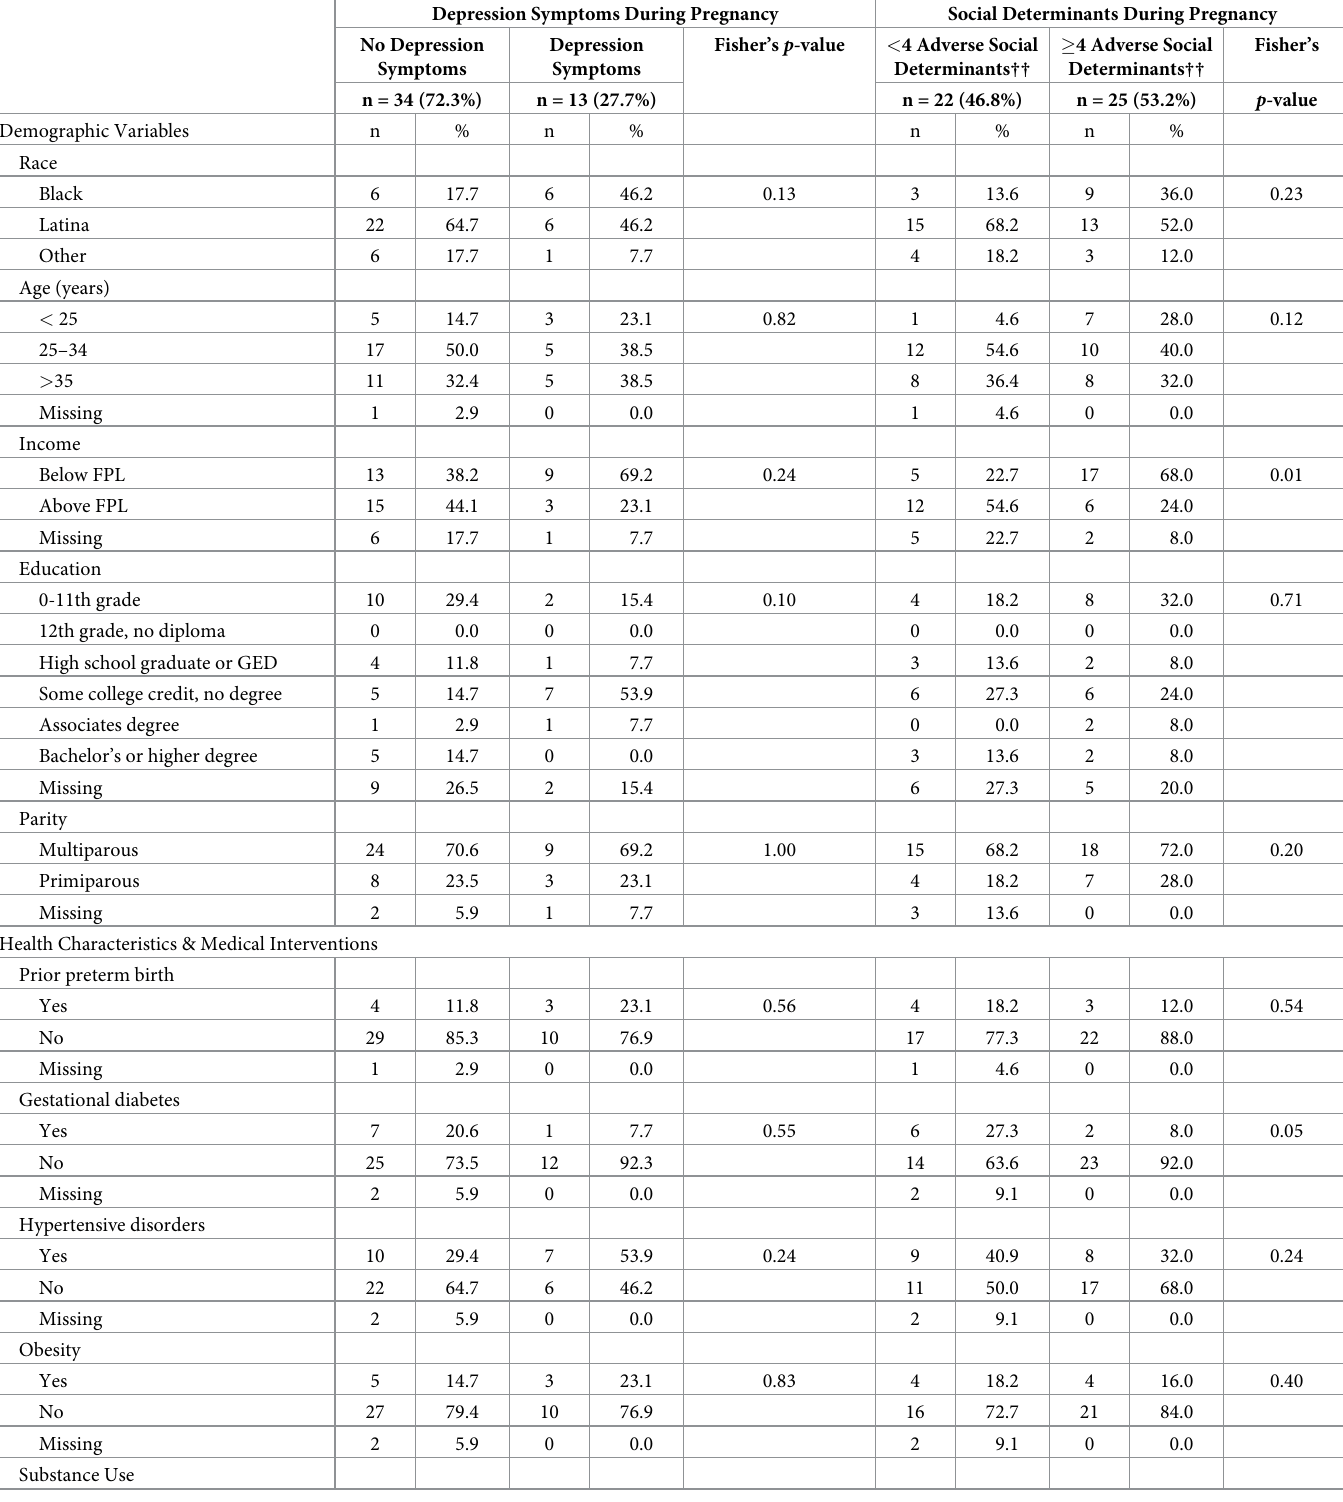
Table 1. Distribution of demographic, health and behavioral health characteristics by depression symptoms and social determinants (n =